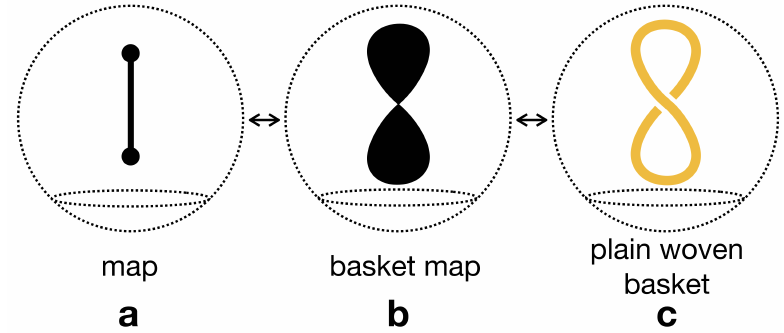
Figure 8. Bijections connecting maps to plain woven baskets: ( a ) A graph drawing on a closed surface, a map ; ( b ) the black vertex dots of the map are enlarged until they meet at the middle of the obscured edges, a basket map ; and ( c ) a plain-woven basket , woven according to the basket map—standing in a black region of the basket map, the weaver sees the surrounding weave crossings as